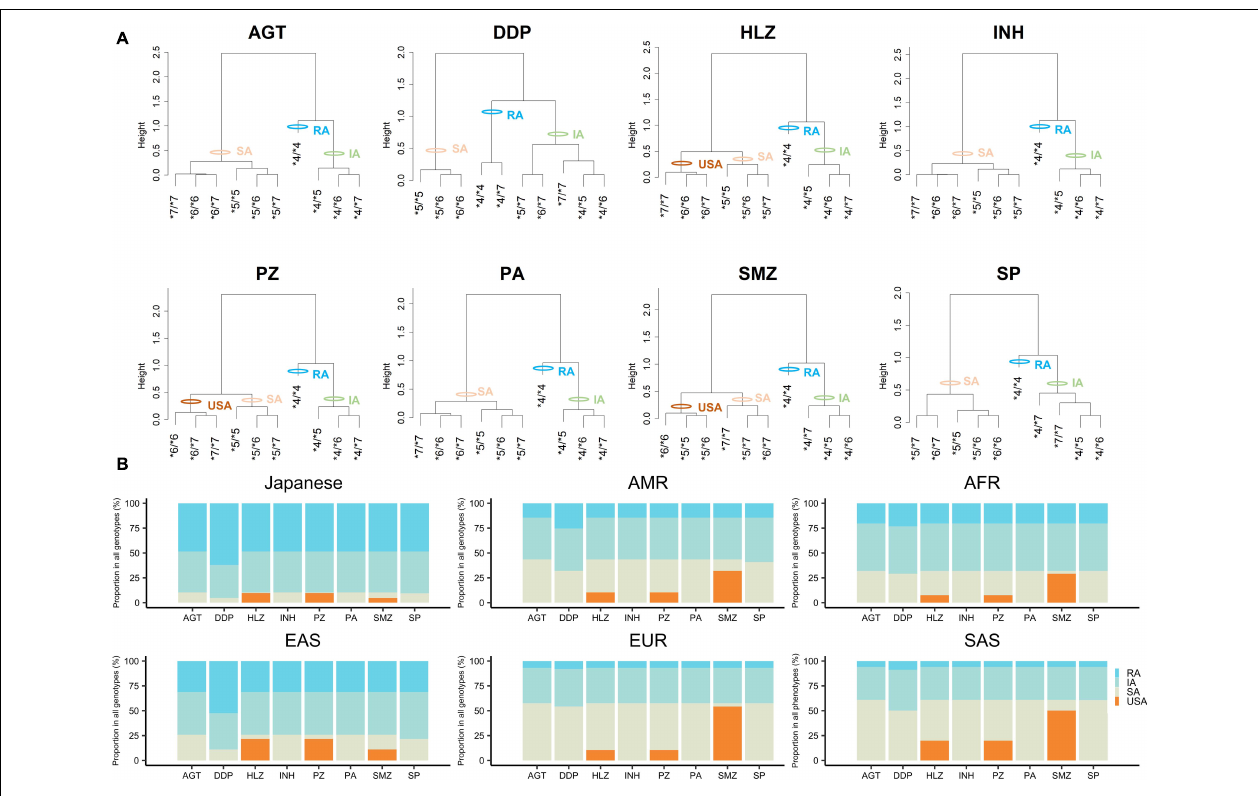
FIGURE 2 | Categorization of NAT2 genotypes into phenotypes by hierarchical cluster analysis based on activity scores and worldwide distribution of NAT2 phenotypes for different substrate drugs. (A) Cluster dendrograms using activity scores of NAT2 genotypes for eight drugs and categorization of NAT2 genotypes into the different phenotypes. (B) Proportion of predicted NAT2 phenotypes for each drug in Japanese, AFR, AMR, EAS, EUR, and SAS